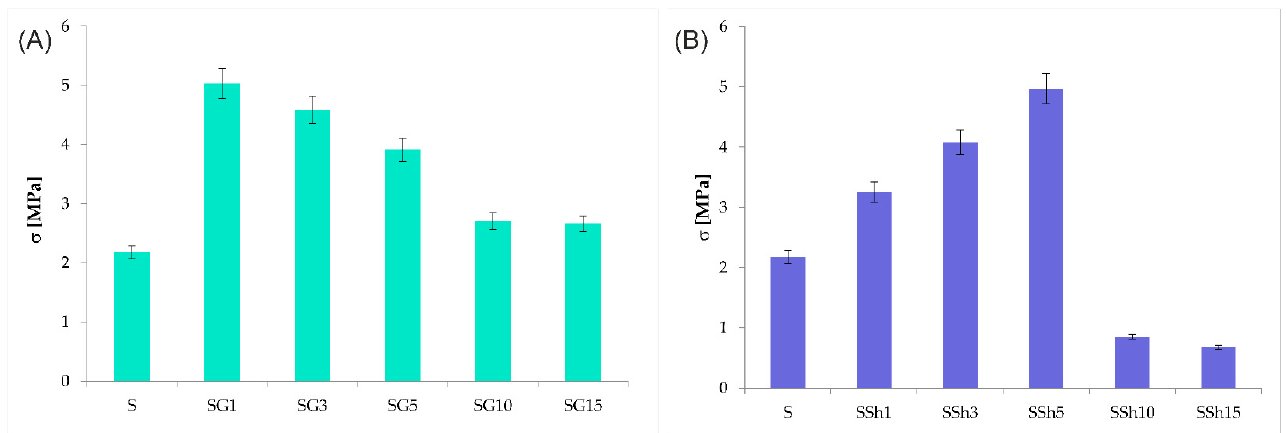
Figure 12. Tensile strength of pure Sylgard and its composites with an addition of ( A ) graphite and ( B ) shungite. ( B )